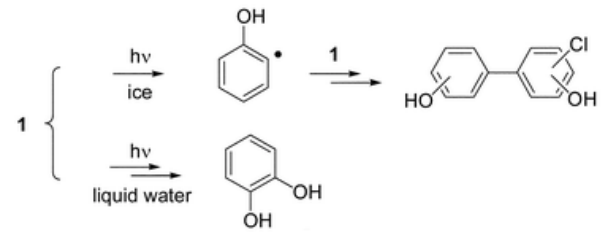
Fig. 16. Major photolysis products of 2-chlorophenol (1) in ice and in water. In ice chlorobiphenyldiol coupling products are found, in water 2-chlorophenol forms pyrocatechol. Reproduced from Klánová et al. (2003a) with permission from The Royal Society of